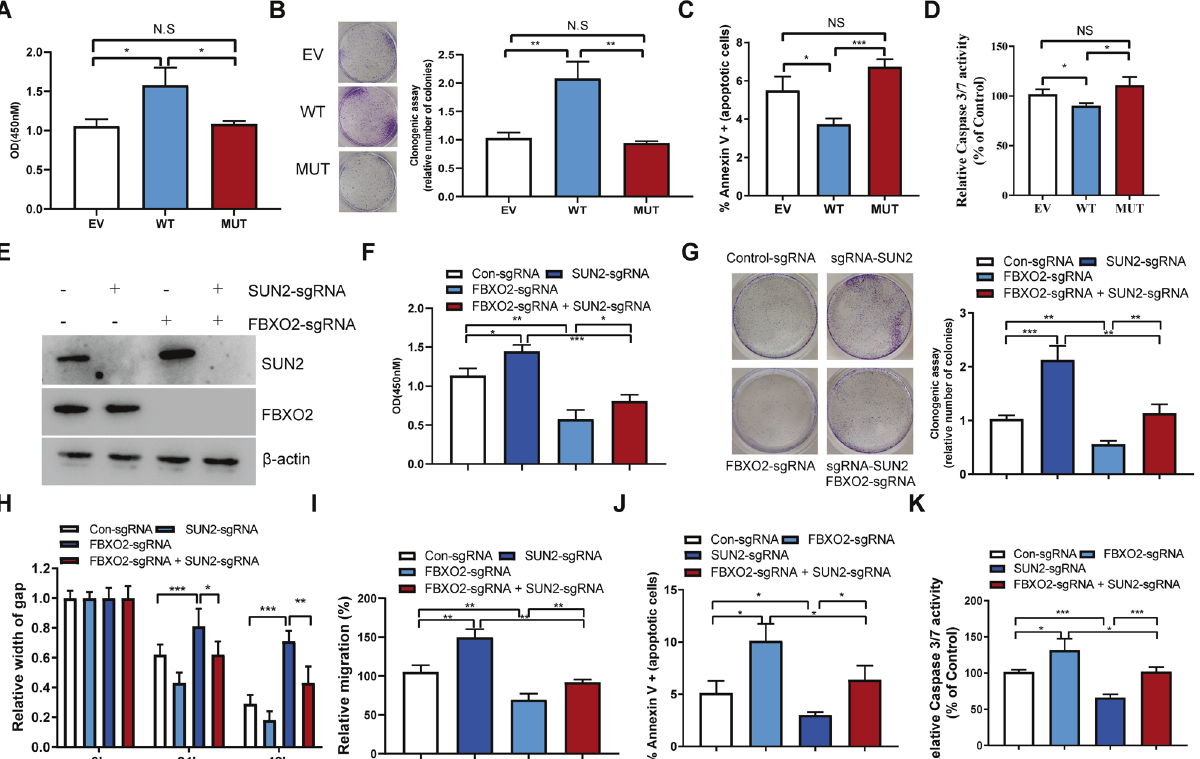
Fig. 6 FBXO2 promoted the progress of OV partially by degrading SUN2. A Cell proliferation in A2780 cells transfected with EV or FBXO2WT or FBXO2 MUT plasmids were assessed by CCK-8 assay. B Quanti fi cation of a colony-formation assay of the A2780 cells in ( A ). C A2780 cells transfected with indicated plasmids were analyzed by FACS with Annexin V-PI assay. The graph represents the percentage of Annexin V positive cells. D Caspase3 and Caspase7 activity were measured in A2780 cells transfected with indicated plasmids. E The lysate of A2780 cells transfected with indicated sgRNAs was immunoblotted with the speci fi ed antibodies. F Cell proliferation in A2780 cells from ( E ) was assessed by CCK-8 assay. G Quanti fi cation of a colony-formation assay of the A2780 cells from ( E ). H The gap width in A2780 cells from ( E ) was measured at 24 and 48 h, respectively. I The relative migration rate of A280 cells from ( E ). J A2780 cells transfected with indicated sgRNAs were analyzed by FACS with Annexin V-PI assay. The graph represents the percentage of Annexin V positive cells. K Caspase3 and Caspase7 activity were measured in A2780 cells transfected with indicated